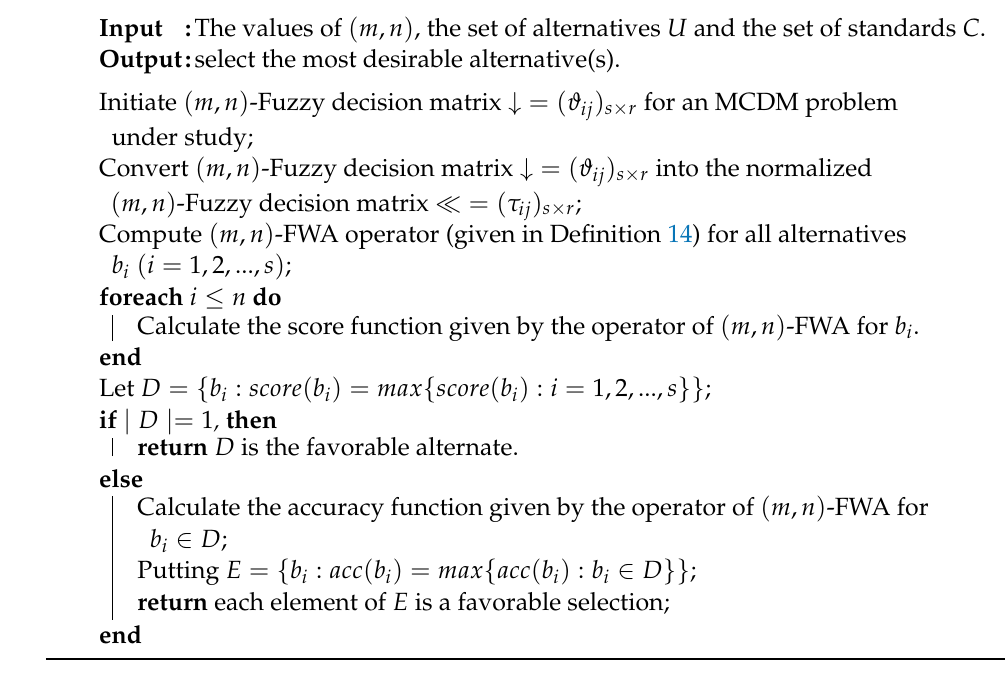
Algorithm 1: The optimal alternative(s) induced from the operator of ( m , n ) -FWA.